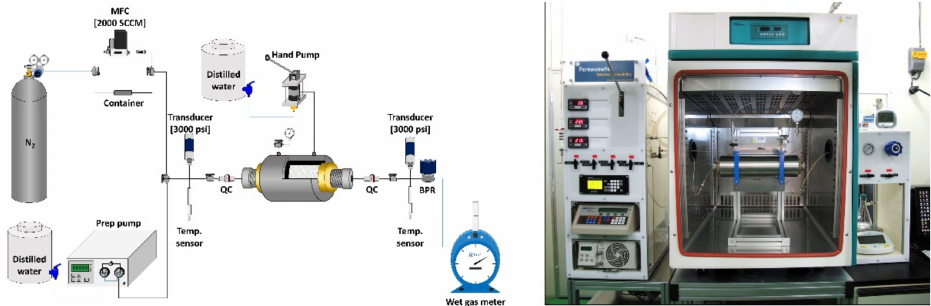
Figure 6. Permeability measurement using the broadband rock permeability measurement